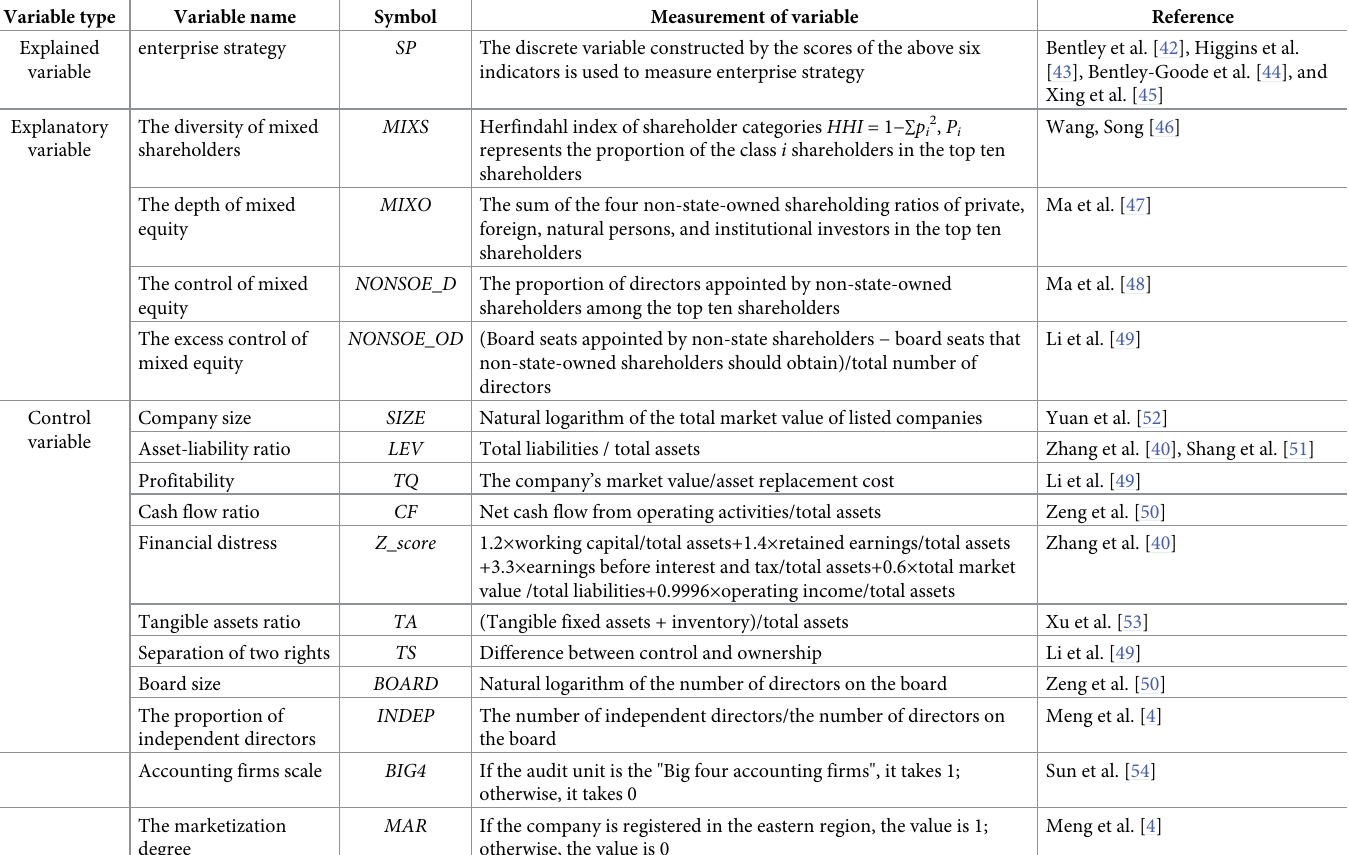
Table 1. The variable definition and